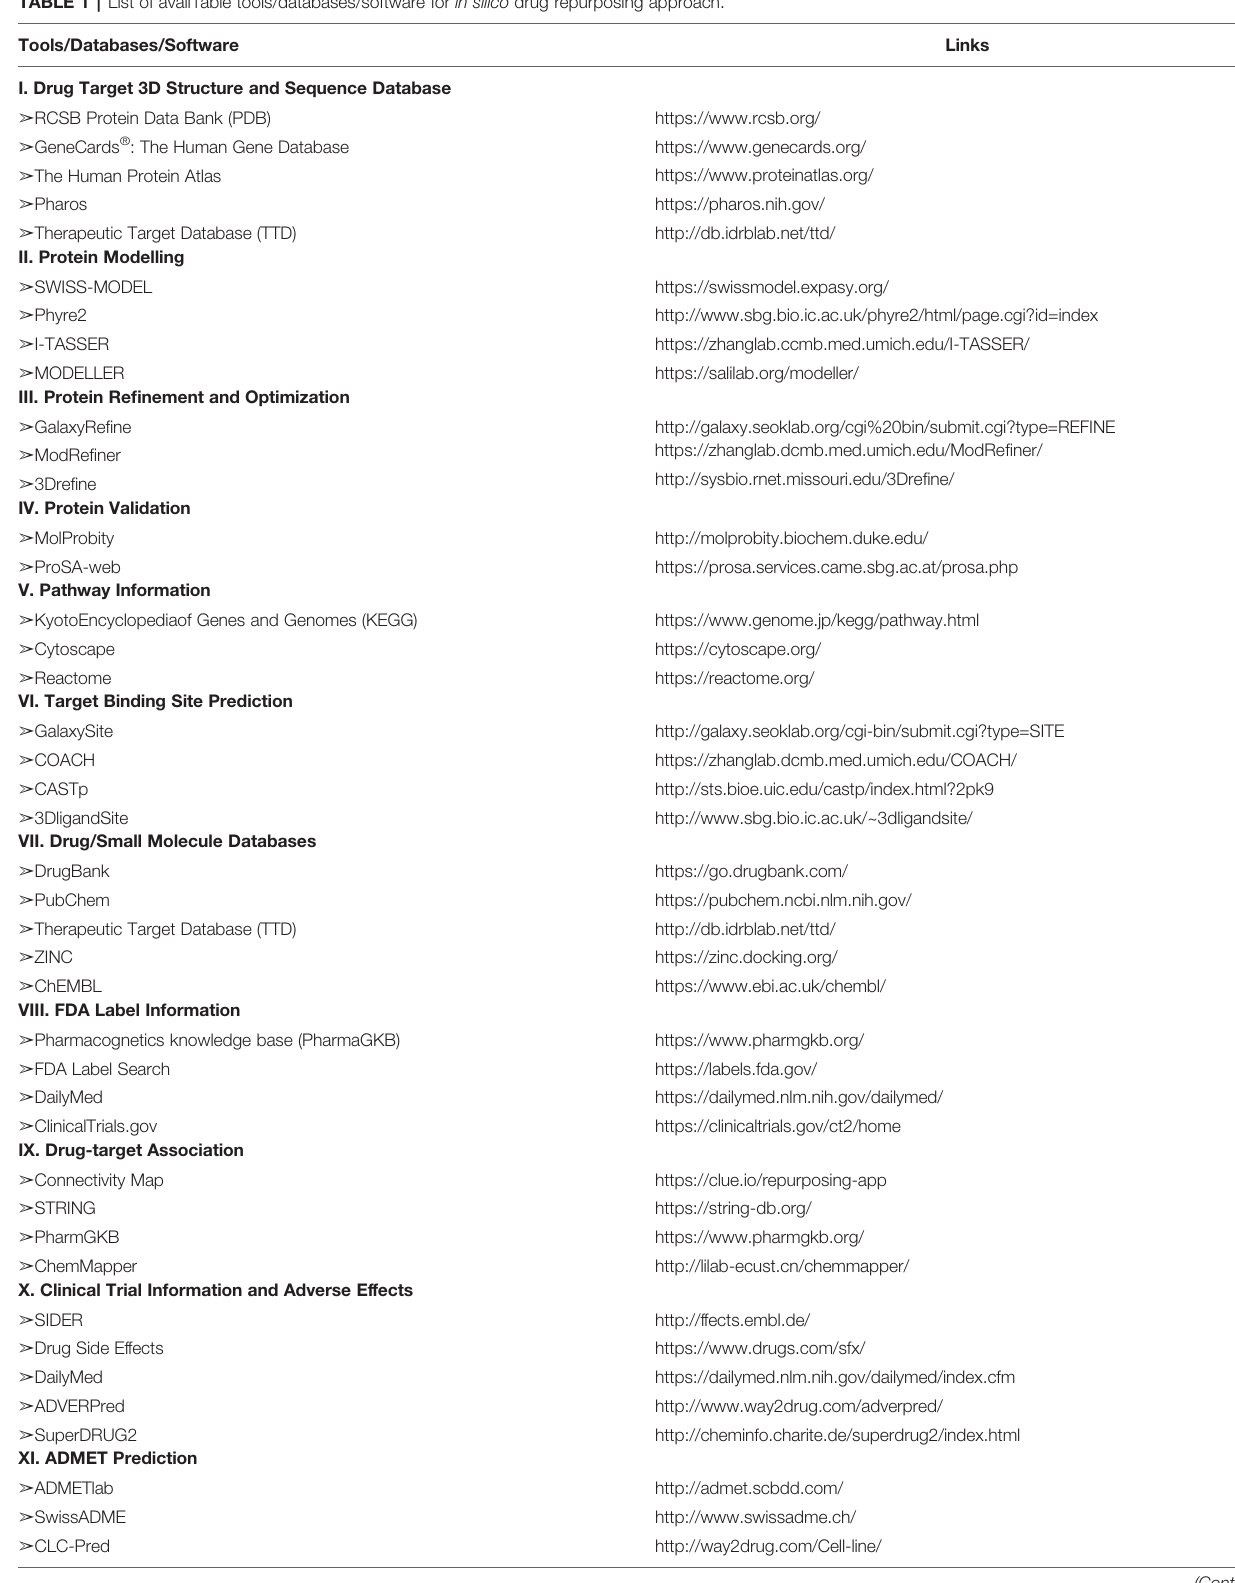
TABLE 1 | List of avail1able tools/databases/software for in silico drug repurposing approach. Tools/Databases/Software Links I. Drug Target 3D Structure and Sequence